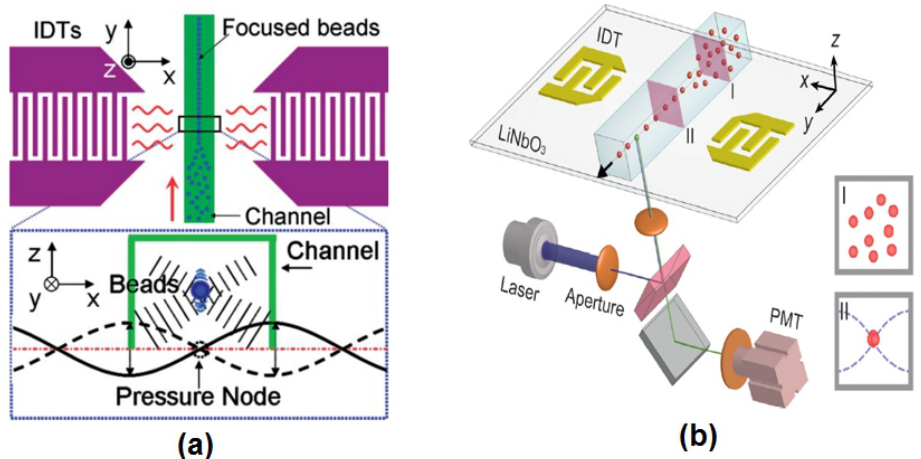
Figure 3. ( a ) A schematic diagram of standing surface acoustic waves (SSAW) focusing. The pressure node located at the center of the microchannel was generated by the SSAW field created by two parallel interdigital transducers (IDTs). When particles or cells enter the SSAW field, the acoustic radiation force (vertically and horizontally) moves the particles to the pressure node. Reprinted from [39] with kind permission from Royal Society of Chemistry. ( b ) A schematic diagram of a SSAW-based microflow cytometer. Reprinted from [41] with kind permission from Royal Society of